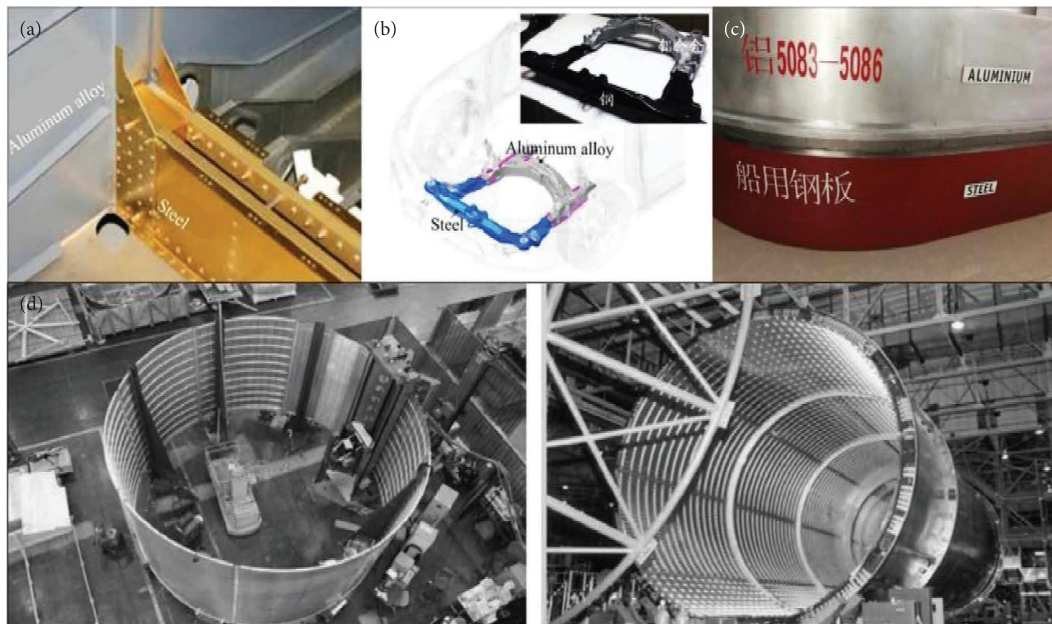
Figure 1: Applications show dissimilar joints using Al and steel (a) aerospace, (b) automobile, (c) marine industries [10],and (d) space applications [11].